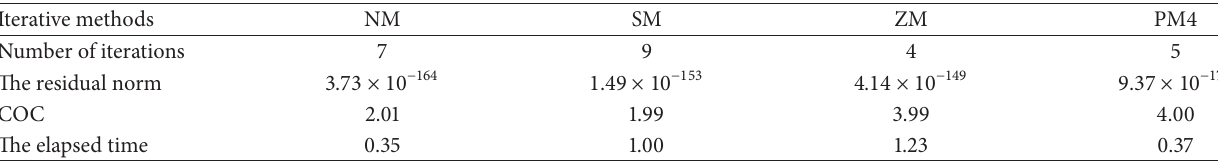
Table 1: Results of comparisons for different methods in Test 1 using x (0) = (1.88 + 0.2𝐼 , 0.57 − 2.01𝐼 , 1.00 − 0.27𝐼 , 2.94 + 0.83𝐼 , 0.84 − 0.13𝐼 ,